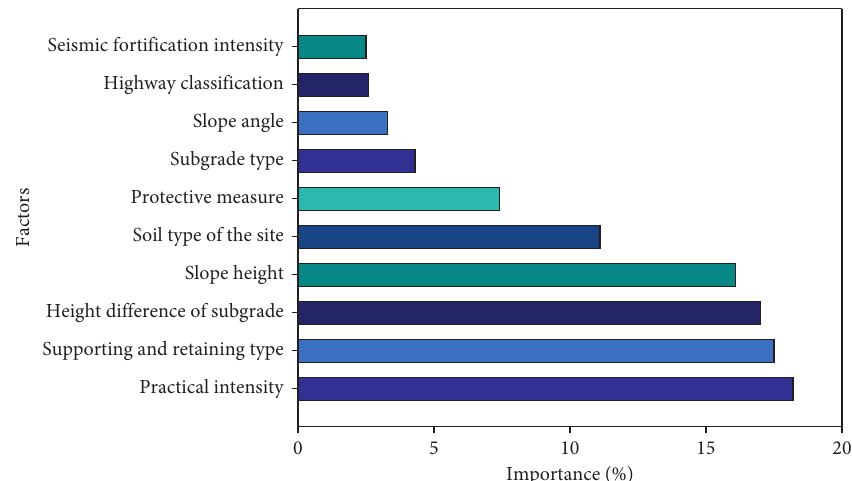
Figure 3: The importance values of factors of the seismic road damage based on the AdaBoost algorithm.